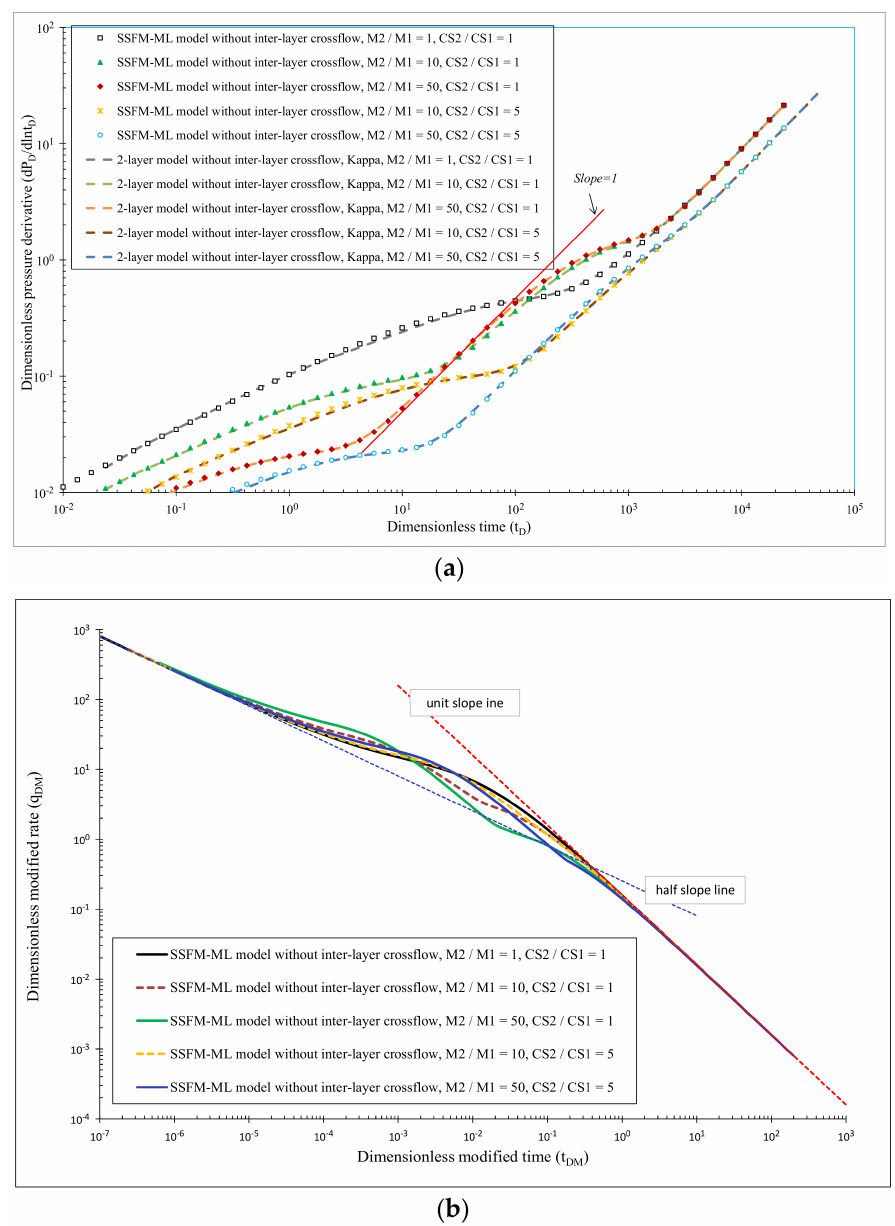
Figure 13. ( a ) Dimensionless pressure derivative dp D / dln ( t D ) vs. dimensionless time t D and ( b ) modified dimensionless rate q DM vs. modified dimensionless time t DM , under various M 2 /M 1 and C S2 /C S1 ratios. Each layer has different reservoir length and width as well as different fracture length and fracture height, with 2 L f 1 D = 20, 2 L f 2 D = 10, N stage = 1; x e 1 D = y e 1 D = 100, x e 2 D = y e 2 D =